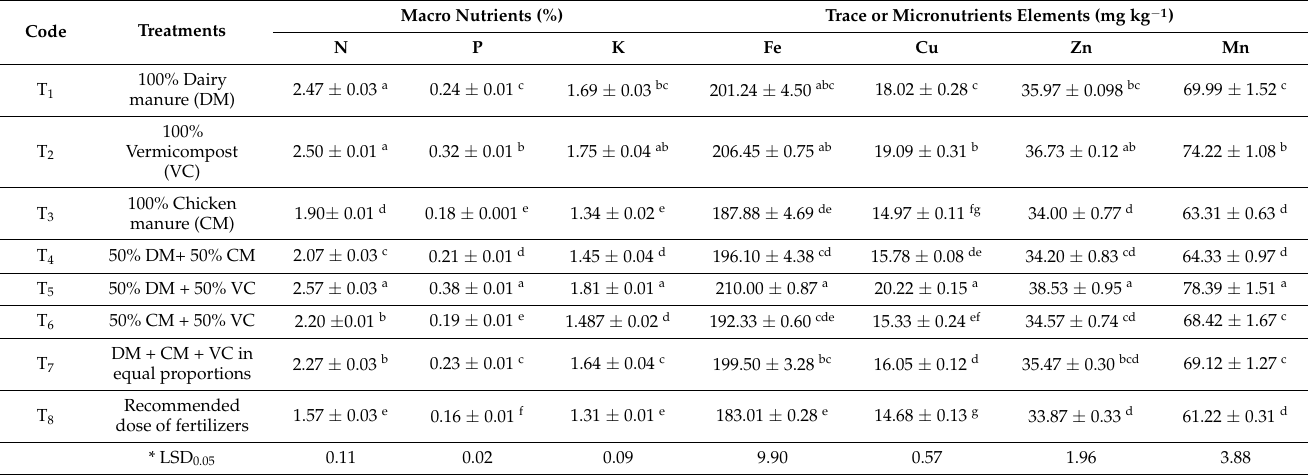
Table 3. Impact of organic manures on leaf nutrients status of Actinidia deliciosa cv